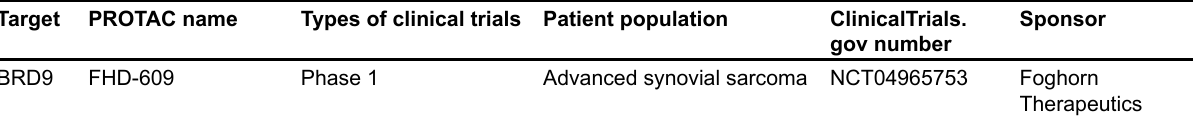
Table 2. Summary of ongoing clinical trials of PROTAC degraders ( continued ) Target